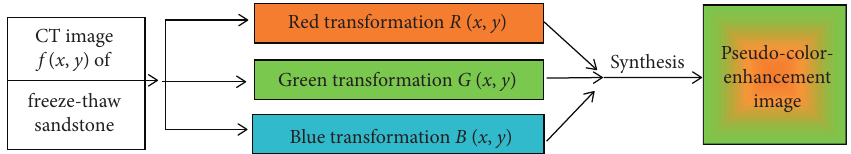
Figure 7: Flowchart of the transformation from gray level images to multicolor